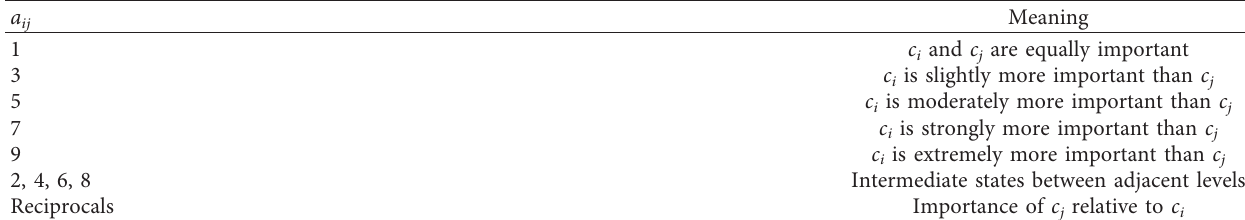
Table 1: The 9-point scale for pairwise comparison.